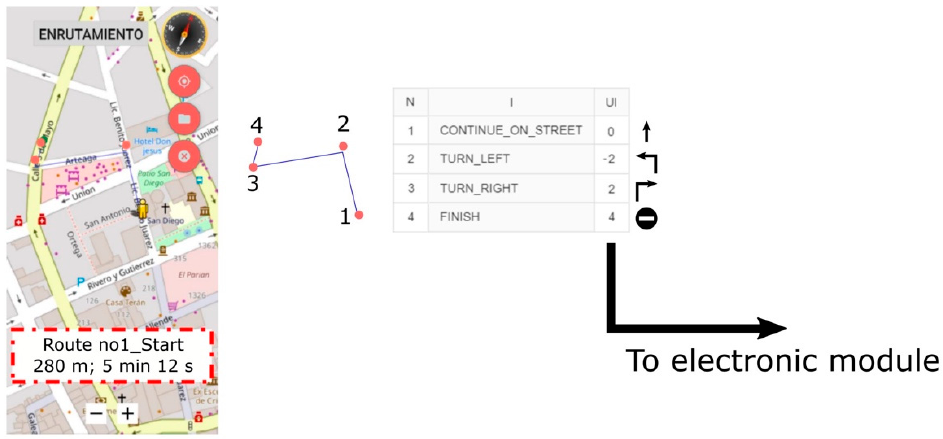
Figure 10. The first environment proposed to the subjects. Four nodes (orange circles) are needed to reach the destination. Table: the app assigns an instruction (column I) to each node (column N). The user interface number (column UI) associated to each instruction is sent to the electronic module when the user approaches the node. Instructions for “continue_on_street” and “finish” are F and S, respectively.